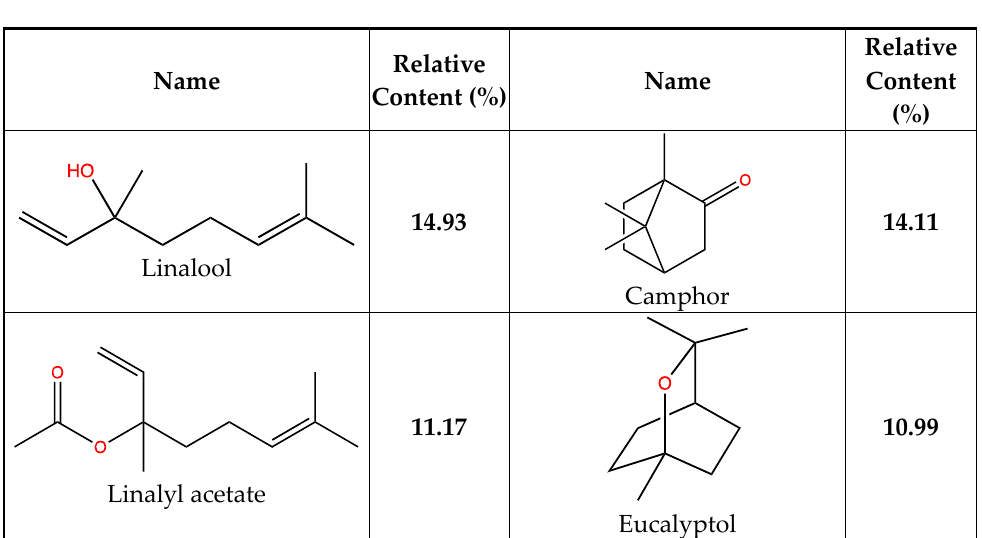
Figure 1. Developed formula and relative content of major L. officinalis essential oil identified com- pounds (Table 1). compounds (Table